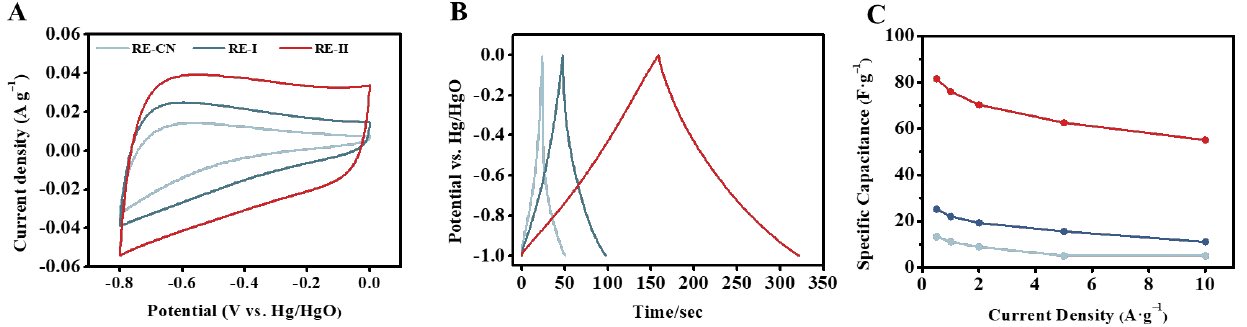
Figure 6. Electrochemical properties of the porous carbon generated by 1:2 ( w / w ) FeCl 3 -activated thermal–chemical conversion of the lignocellulose residues (RE) from T. reesei incubation with raw ZH stalk co-supplied with 0.05% FeCl 3 . ( A – C ) For the three carbon samples generated from RE-I (Raw + 0.05% FeCl 3 ), RE-II (Raw + 0.05% FeCl 3 ) + 1:2 FeCl 3 and RE-CN (raw, incubated with T. reesei without FeCl 3 ): ( A ) Cyclic-voltammetry curves at 100 mV s −1 ; ( B ) galvanostatic charge/discharge curves at 0.5 A/g; ( C ) specific capacitance calculated by galvanostatic charge–discharge at different current densities.